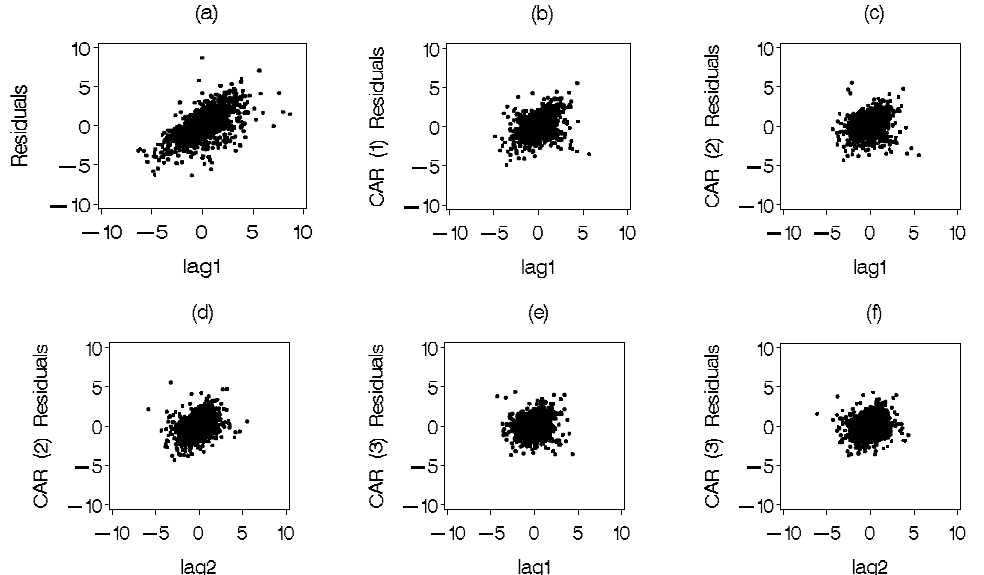
Figure 1. An example of d residuals plotted against Lag1 and Lag2 residuals for Clark model fitted without considering the autocorrelation parameters ( a ) and using first ( b ) second ( c , d ) and third ( e , f ) order continuous autoregressive error structures.